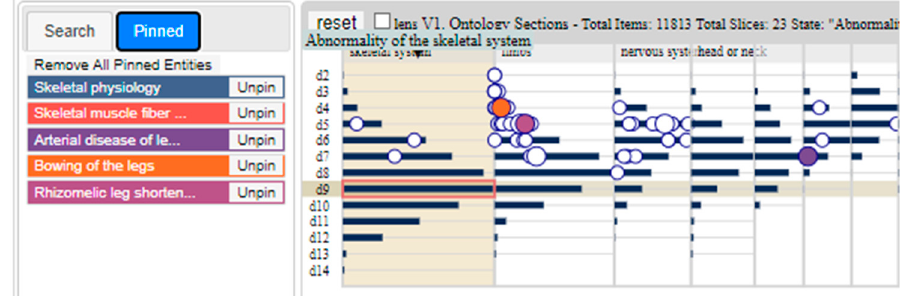
Figure 10. A depiction of Ontology Entity Pinning, where pinned entities are represented in the same fashion as they were found in Ontology Entity Search, with a name label, an Unpin button, and a unique color. We have included a button located at the topmost position of Ontology Entity Pinning labeled ‘Remove All Pinned Entities’. When clicked, this button removes all pinned landmarks from the system. When an ontology entity is removed, its annotated representations will be removed from all subviews.